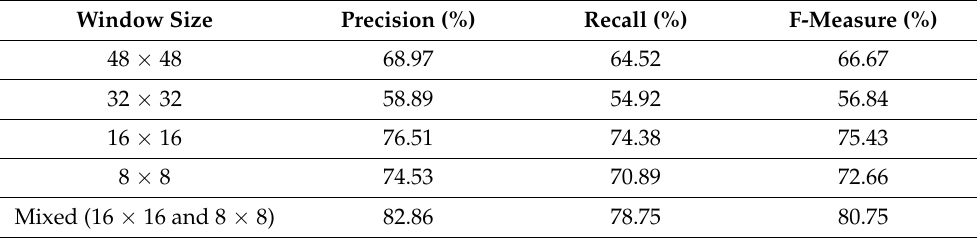
Table 7. Identification results of landslide hazards in different